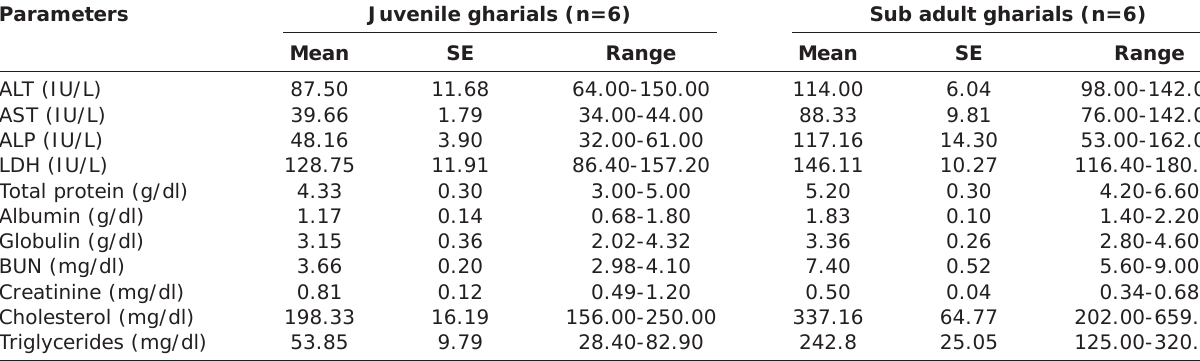
Table-2: Serum biochemical values of juvenile and sub adult gharials ( G. gangeticus ).